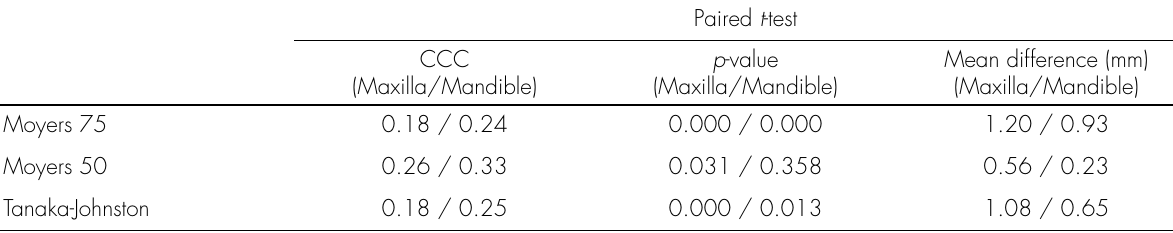
Table II. Maxilla and mandible concordance correlation coefficient with the CBCT and paired t-tests for each pair Model-CBCT (N =